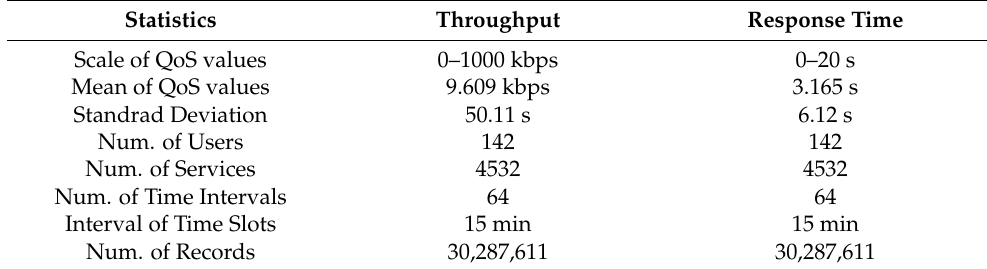
Table 1. The number of